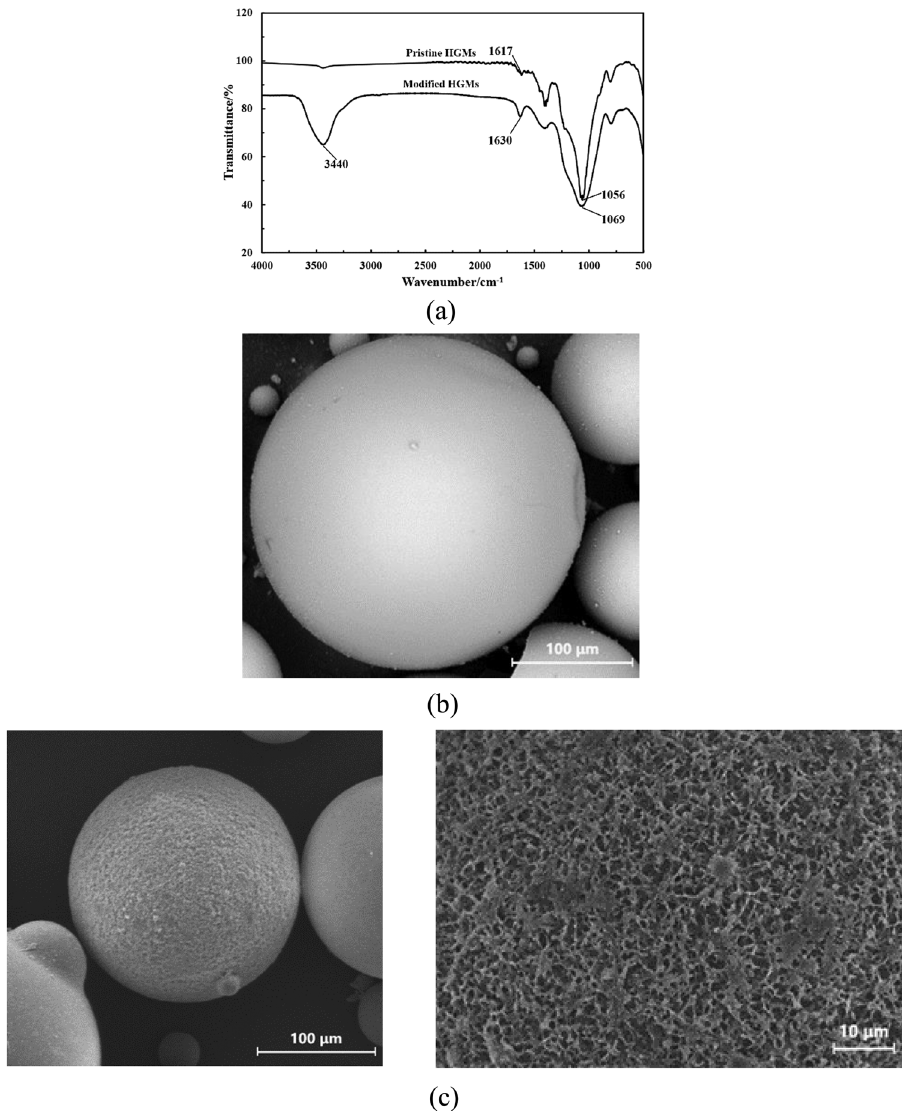
Figure 4: FTIP spectroscopy and SEM images of HGMs: ( a ) FTIP spectra of HGMs, ( b ) SEM image of unmodi fi ed HGMs, and ( c ) SEM images of modi fi ed